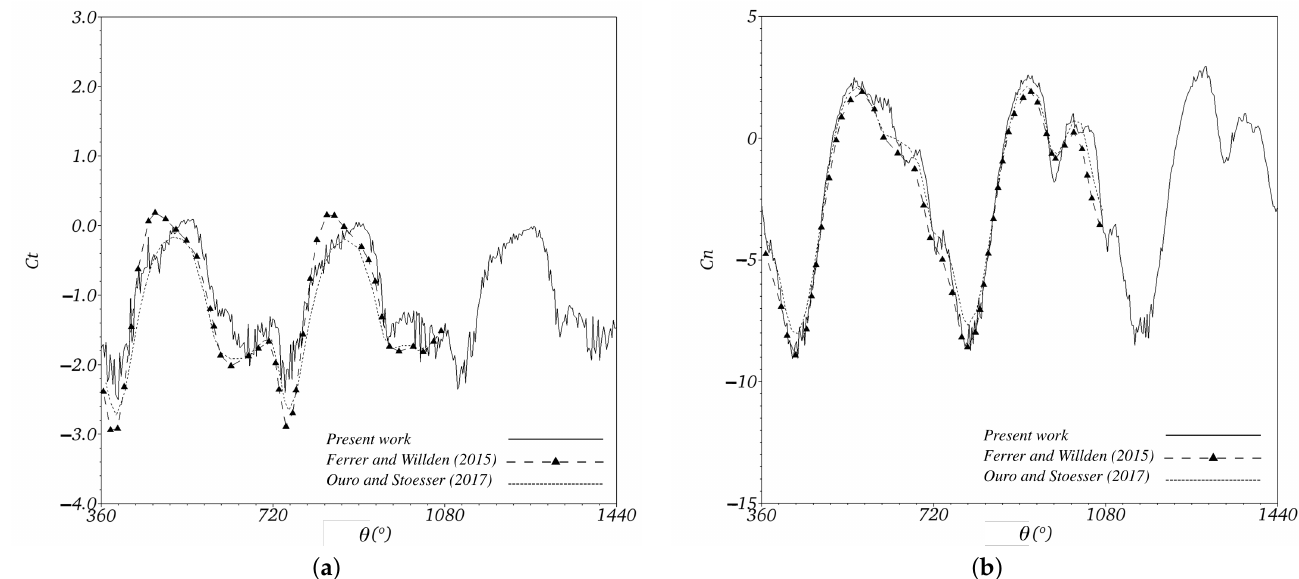
Figure 17. ( a ) Variation of C t as a function of azimuth position θ of a single blade. ( b ) Variation of C n as a function of the azimuthal position θ of a single